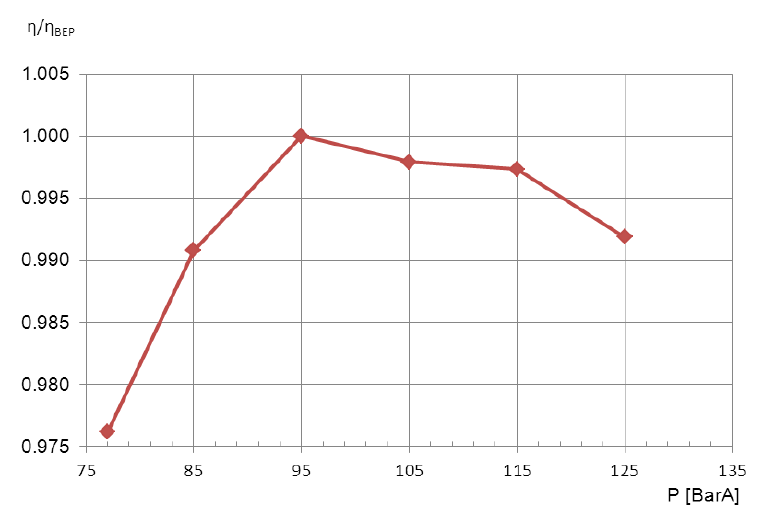
Figure 4. Compression Train calculated polytropic efficiency along the charging cycle (Varying Inlet Guide Vanes).